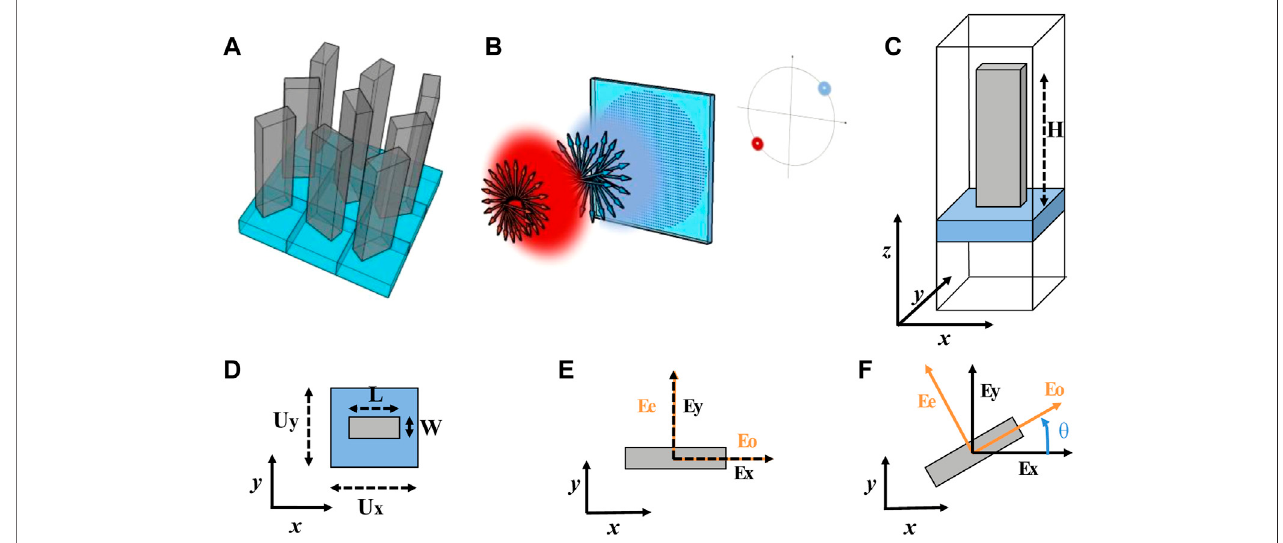
FIGURE 1 | (A) Schematic fi gure representing the 2D array of metaunits composing a metalens. (B) Working principle of a dual-functional metalens: two different structuredbeamsaregeneratedatdistinctpointsinspace,dependingonthehandednessofthecircularpolarizationininput. (C) 3Dviewofametaunit. (D) Topviewofa metaunit illustrating its geometric features: length ( L ), width ( W ), and periods of the 2D array (in our case U x = U y = 400 nm ). (E) Cross section of a pillar representing the extraordinary and ordinary axes forour simulations. Being E e the electric fi eld alongthe extraordinary axis, E o the electric fi eldalong theordinary axis, E x theelectric fi eld along the x -axis, E fi eld along the y -axis, axis and E fi eld, we consider a TE input polarization when E (cid:2) Ex (cid:2) E (cid:2) E (cid:2) 0. o y 0 i and E e y the electric 0 i the input electric Instead, we assume a TM input polarization when E o (cid:2) E x (cid:2) 0 and E e (cid:2) E y (cid:2) E 0 i . (F) Cross section of a pillar showing a rotation θ in order to transfer a geometric phase term equal to 2 θ